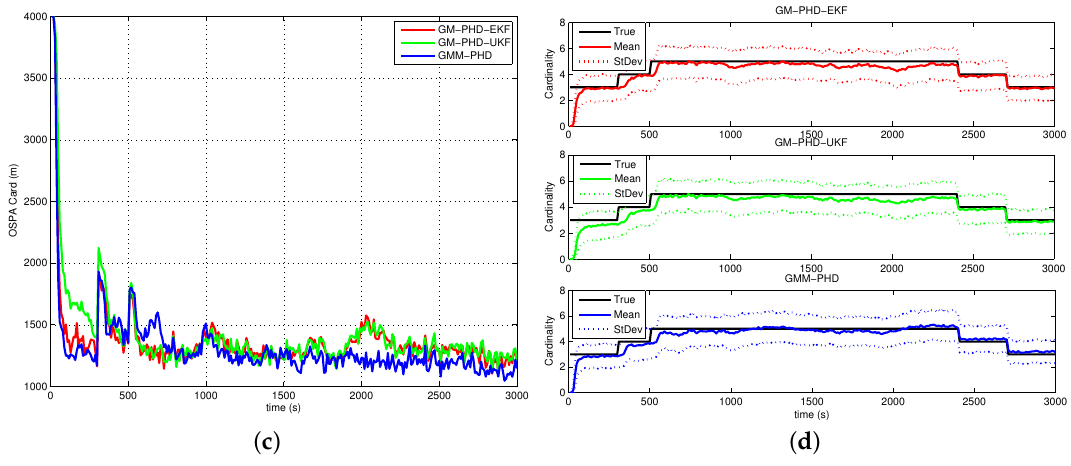
Figure 5. Results of Case 1: ( a ) Optimal subpattern assignment (OSPA) distance; ( b ) OSPA localization; ( c ) OSPA cardinality; ( d ) Cardinality statistics.